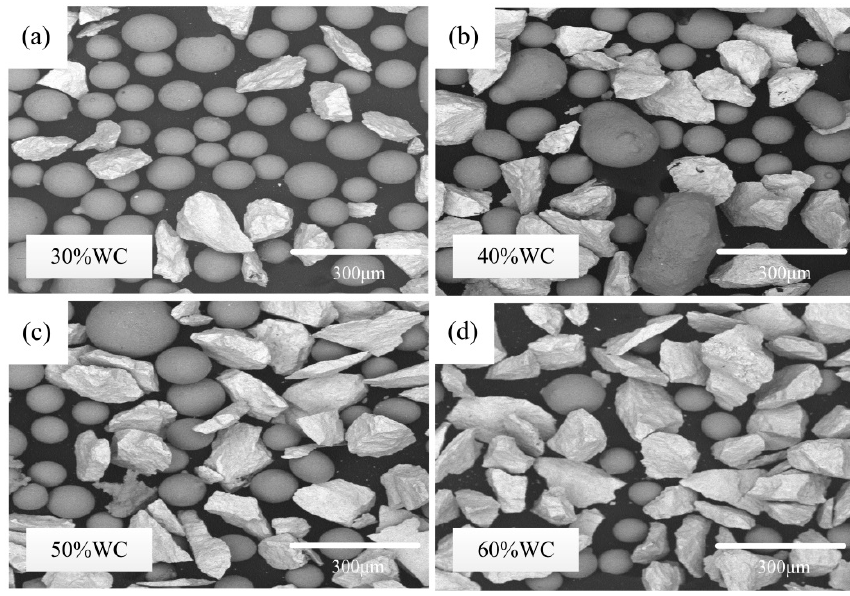
Figure 1. Powder morphologies: ( a ) 30% WC, ( b ) 40% WC, ( c ) 50% WC, and ( d ) 60% WC.